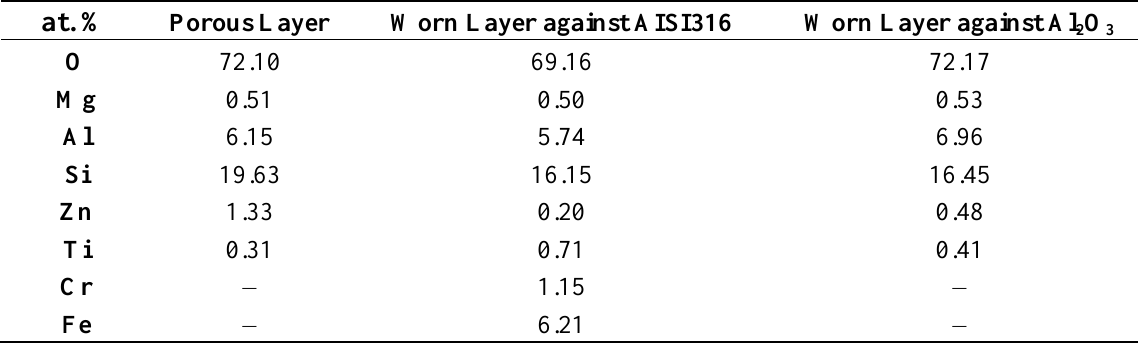
Table 3. EDX Composition of the porous layer before and after wearing tests carried out with AISI316 and Al O 2 3